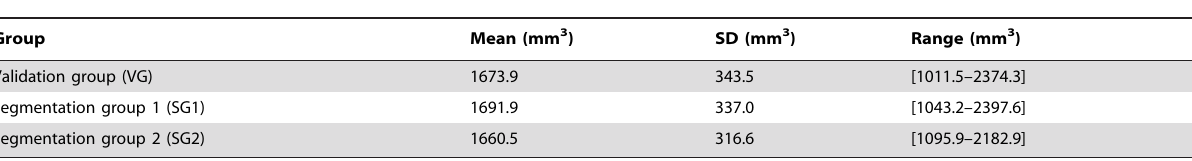
Table 1. Descriptive statistics of condylar